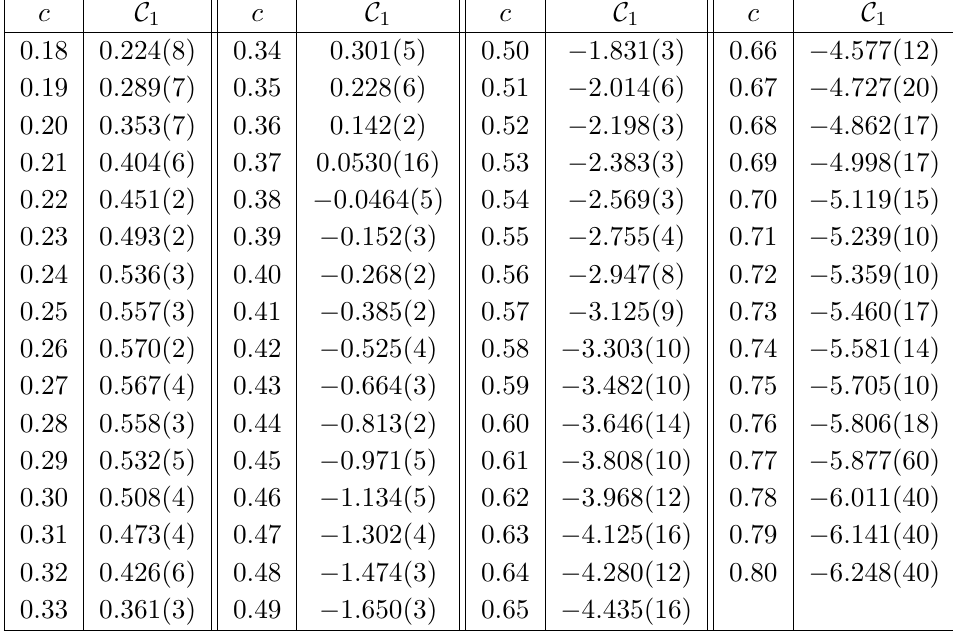
) as a function of c for the SU(3) gauge group and (cid:22) k = 1. MS